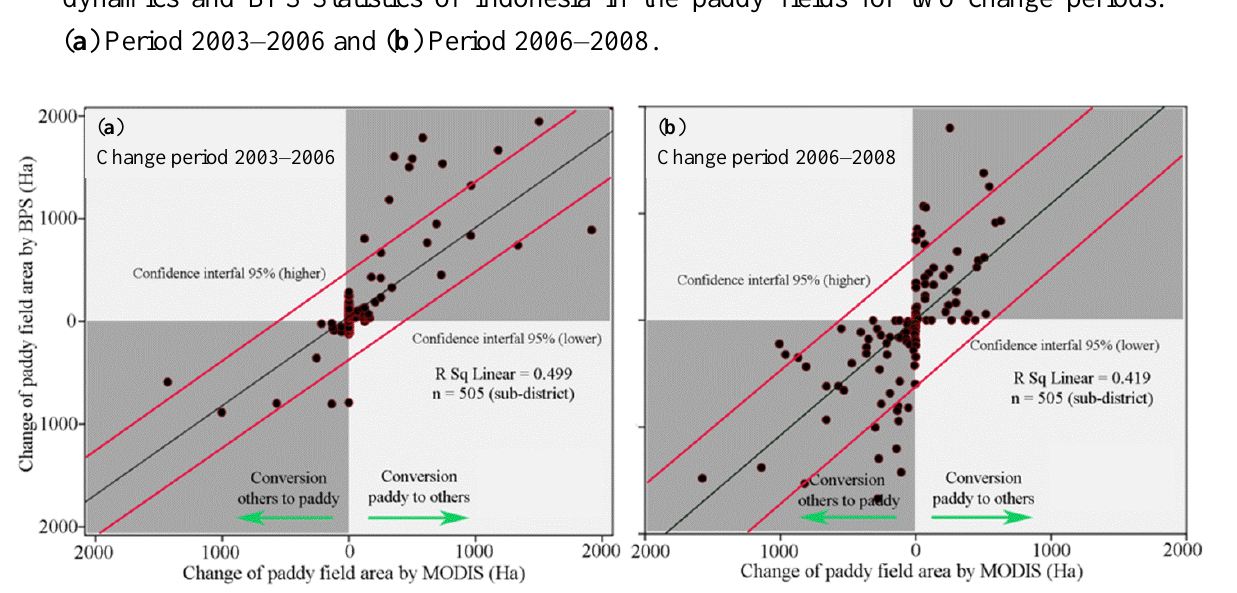
Figure 11. Comparison of the detection results of the change in temporal vegetation dynamics and BPS-Statistics of Indonesia in the paddy fields for two change